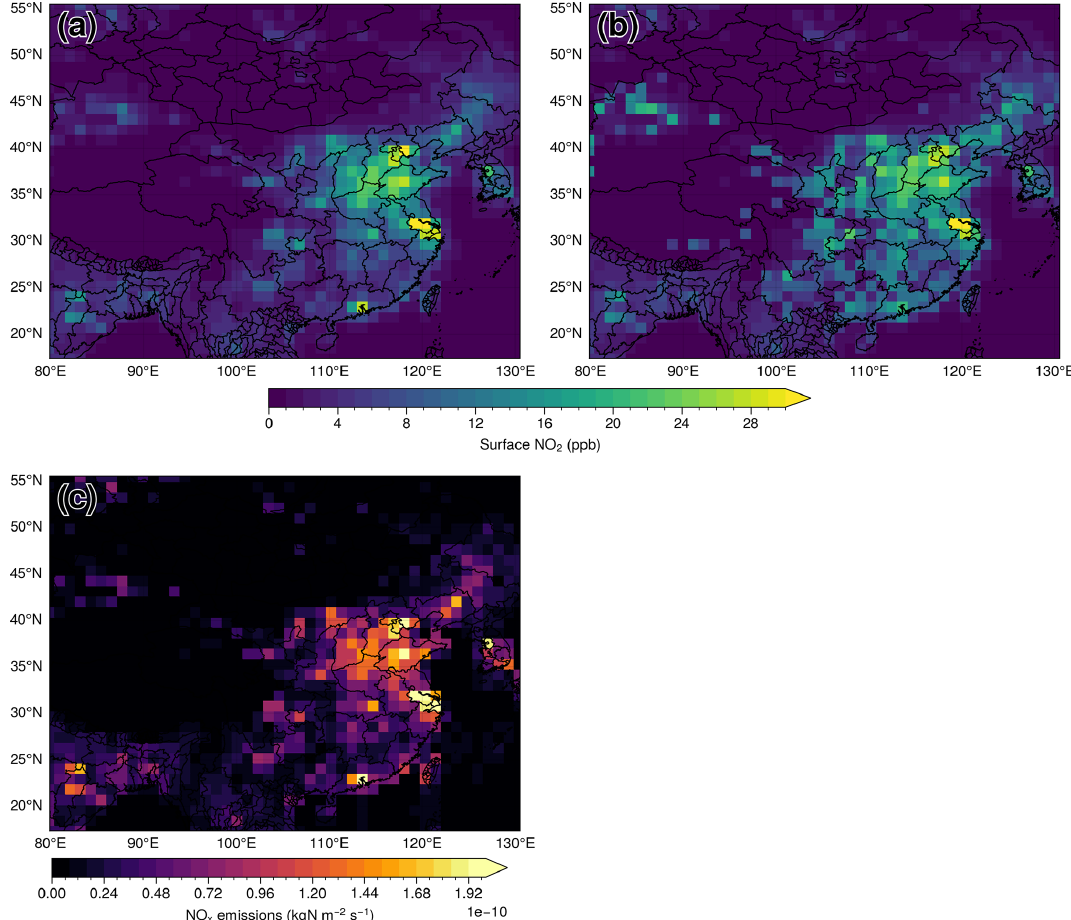
Figure 4. Annual mean (a) TCR-2 surface NO 2 , (b) MEE surface NO 2 with data gaps filled by TCR-2, and (c) TCR-2 NO x emissions for 2019. East China is mostly covered by MEE, but West China has fewer stations and is mostly filled with TCR-2 data in (b) .